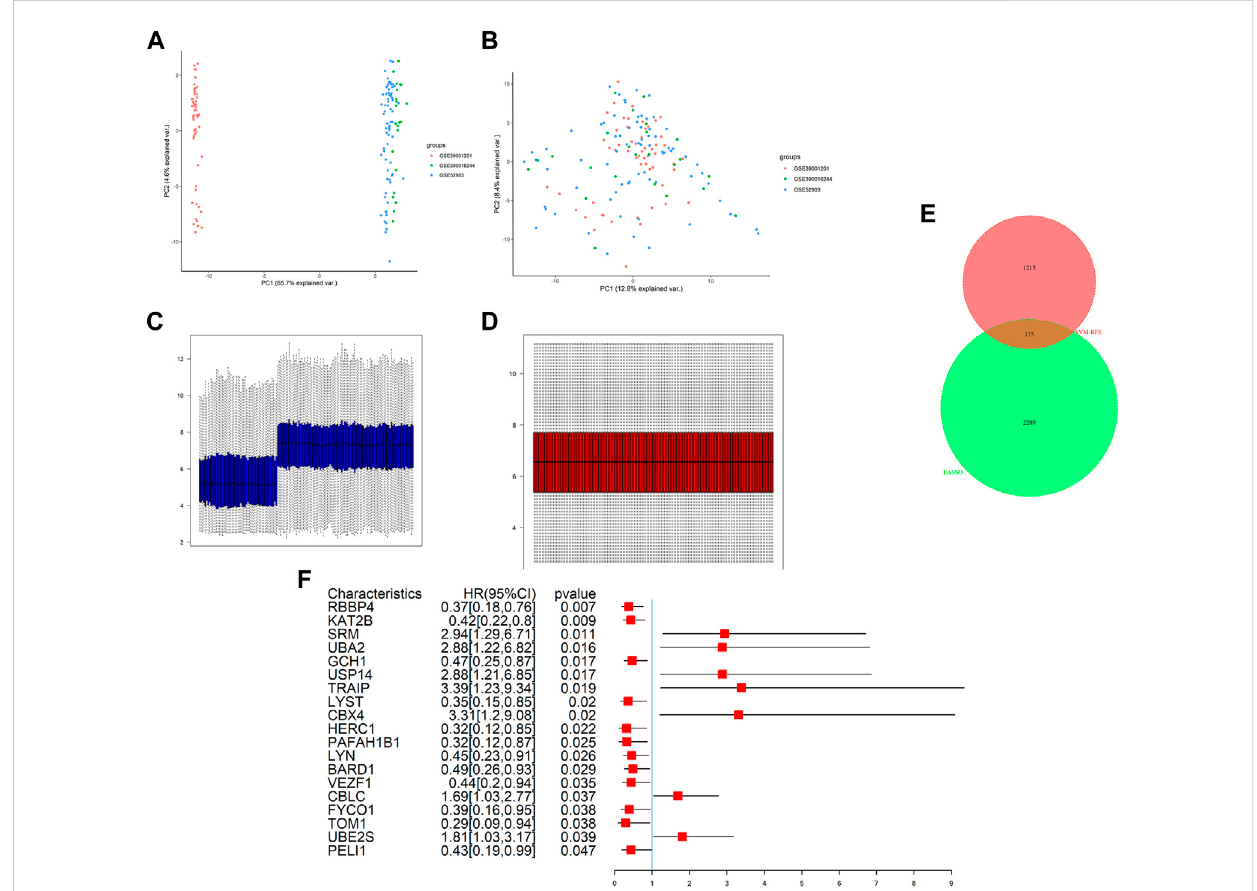
FIGURE 1 Data preprocessing and differential expression analysis. PCA analysis before (A) and after (B) batch effect adjustment and normalization. Barplot before (C) and after (D) batch effect adjustment and normalization. (E) Intersection analysis of DEGs and ubiquitination-related genes. (F) Results of univariate Cox regression analysis of